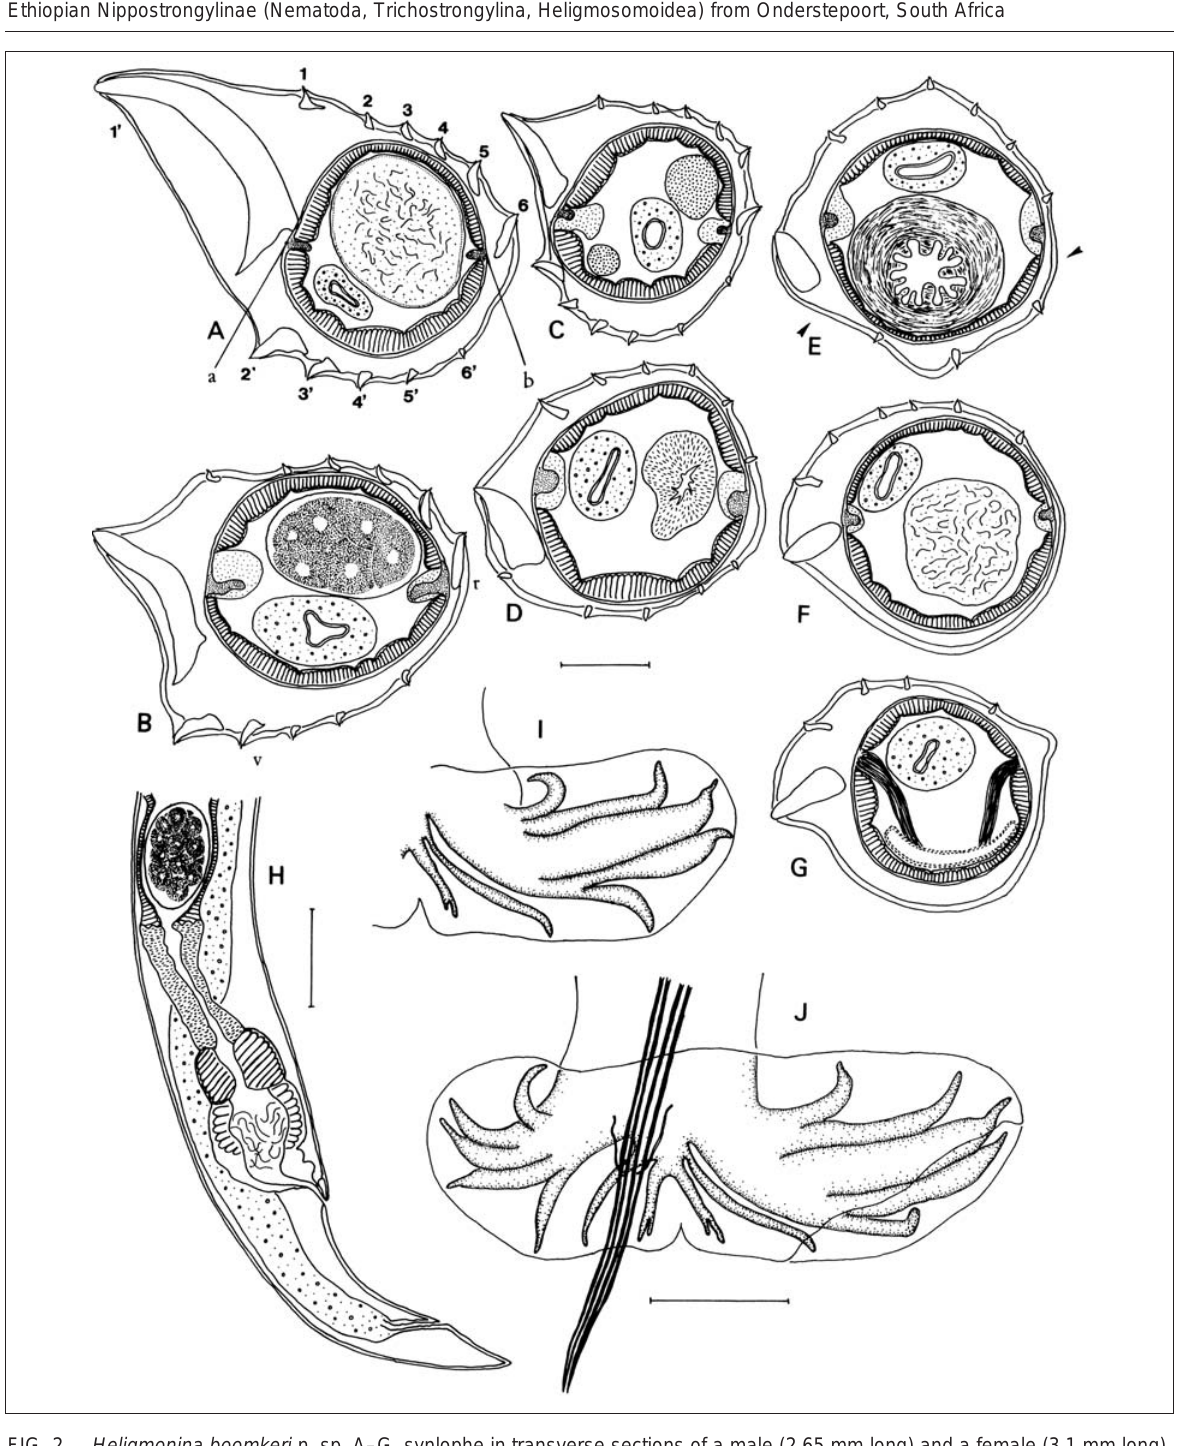
FIG. 2 Heligmonina boomkeri n. sp. A–G, synlophe in transverse sections of a male (2.65 mm long) and a female (3.1 mm long). A, male, at mid-body (900 µm from the apex); B–G, female, B, at mid-body (1.4 mm from the apex), C, at the oesophago- intestinal junction, D, at the level of the distal infundibulum, E, at the level of the sphincter, F, at the level of the distal vestibule, G, just posterior to the vulva. H, female, posterior part, right lateral view. I, male, left lobe of the caudal bursa, ventral view. J, other male, caudal bursa, ventral view The ridges are numbered from left to right from no. 1–6 for the dorsal side, no. 1'–6' for ventral side. The arrows indicate the disappearance of the ridges. All the ridges are orientated as in Fig. 2B Abbreviations: r, right side, v, ventral side, ab: body diameter Scales: A–G: 25 µm; H–J: 50